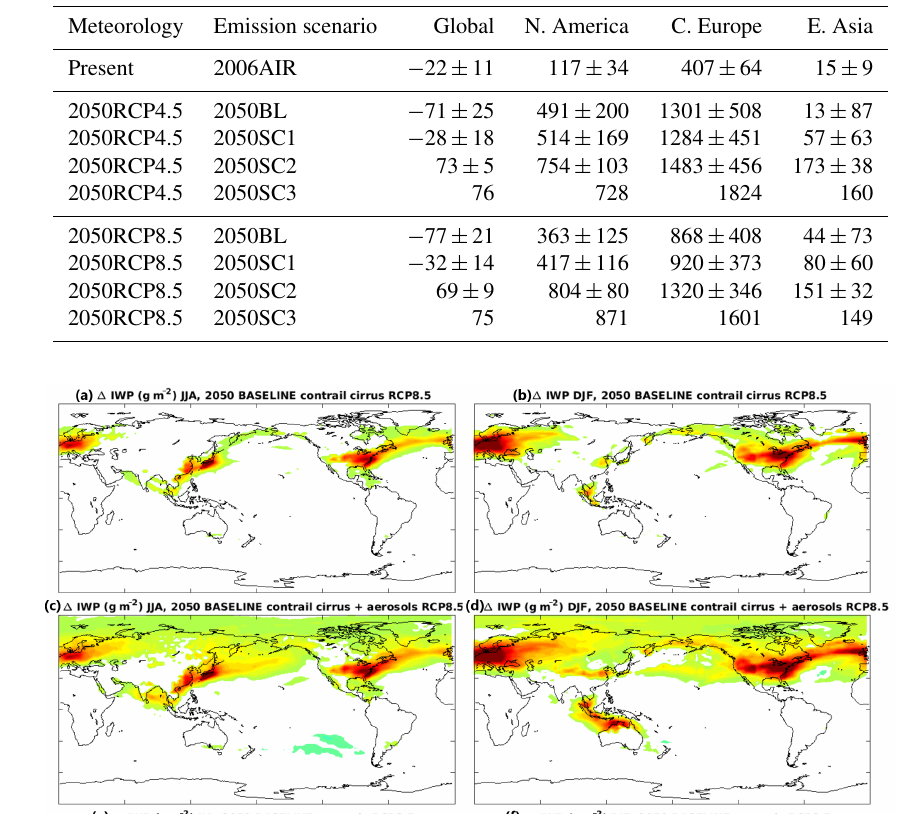
Table 4. Radiative forcing (mWm − 2 ) due to aviation H 2 O + BC + SO 4 emissions. Note that there is no aviation sulfate aerosols in SC2 and SC3. The uncertainties are based on 2 standard deviations of the four-member ensemble.